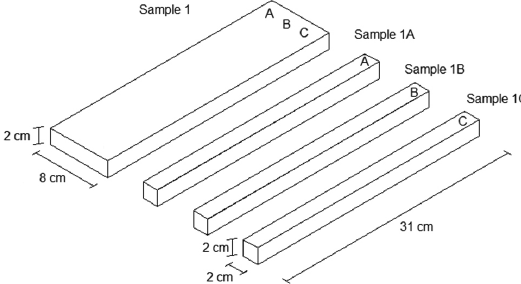
Figure 1. Scheme of wood samples preparation from the Araucaria angustifolia floor. Table 1. Groups for the classification of samples in relation to the level of attack by xylophagous organisms.